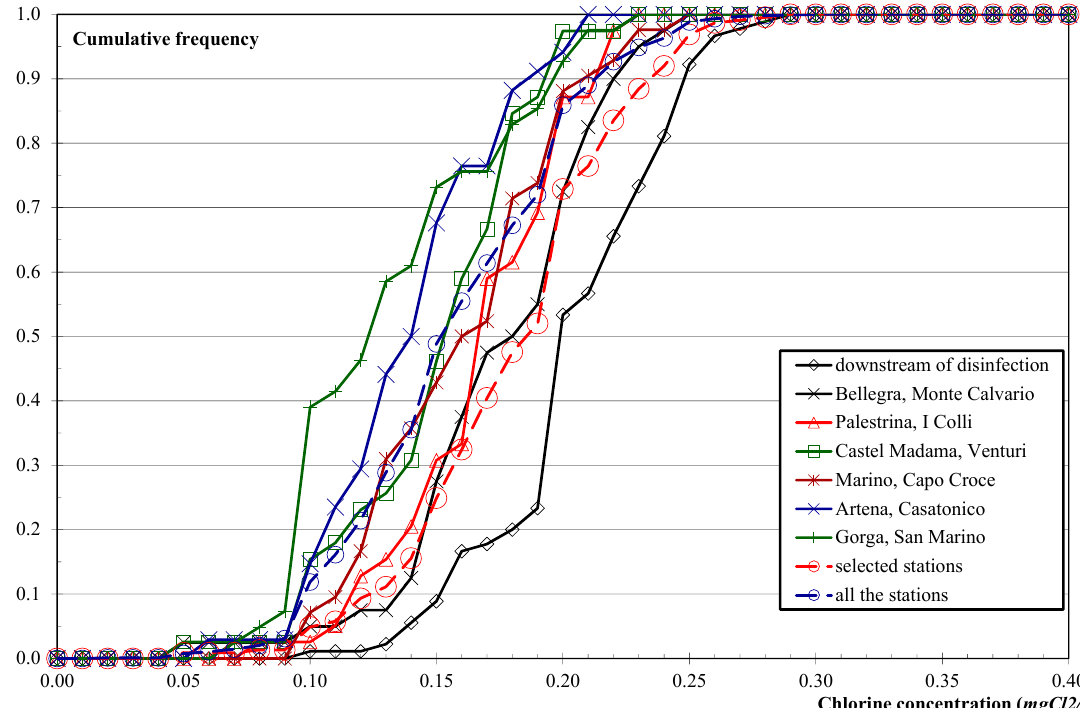
Figure 3. Cumulative frequency of the chlorine concentration (Mg Cl 2 /L) observed in sampling stations.